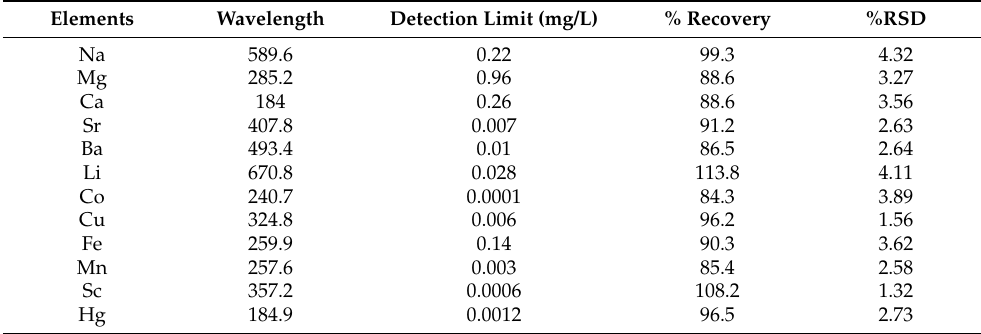
Table 2. Selected elements and corresponding wavelengths (nm), detection limits, % recovery and